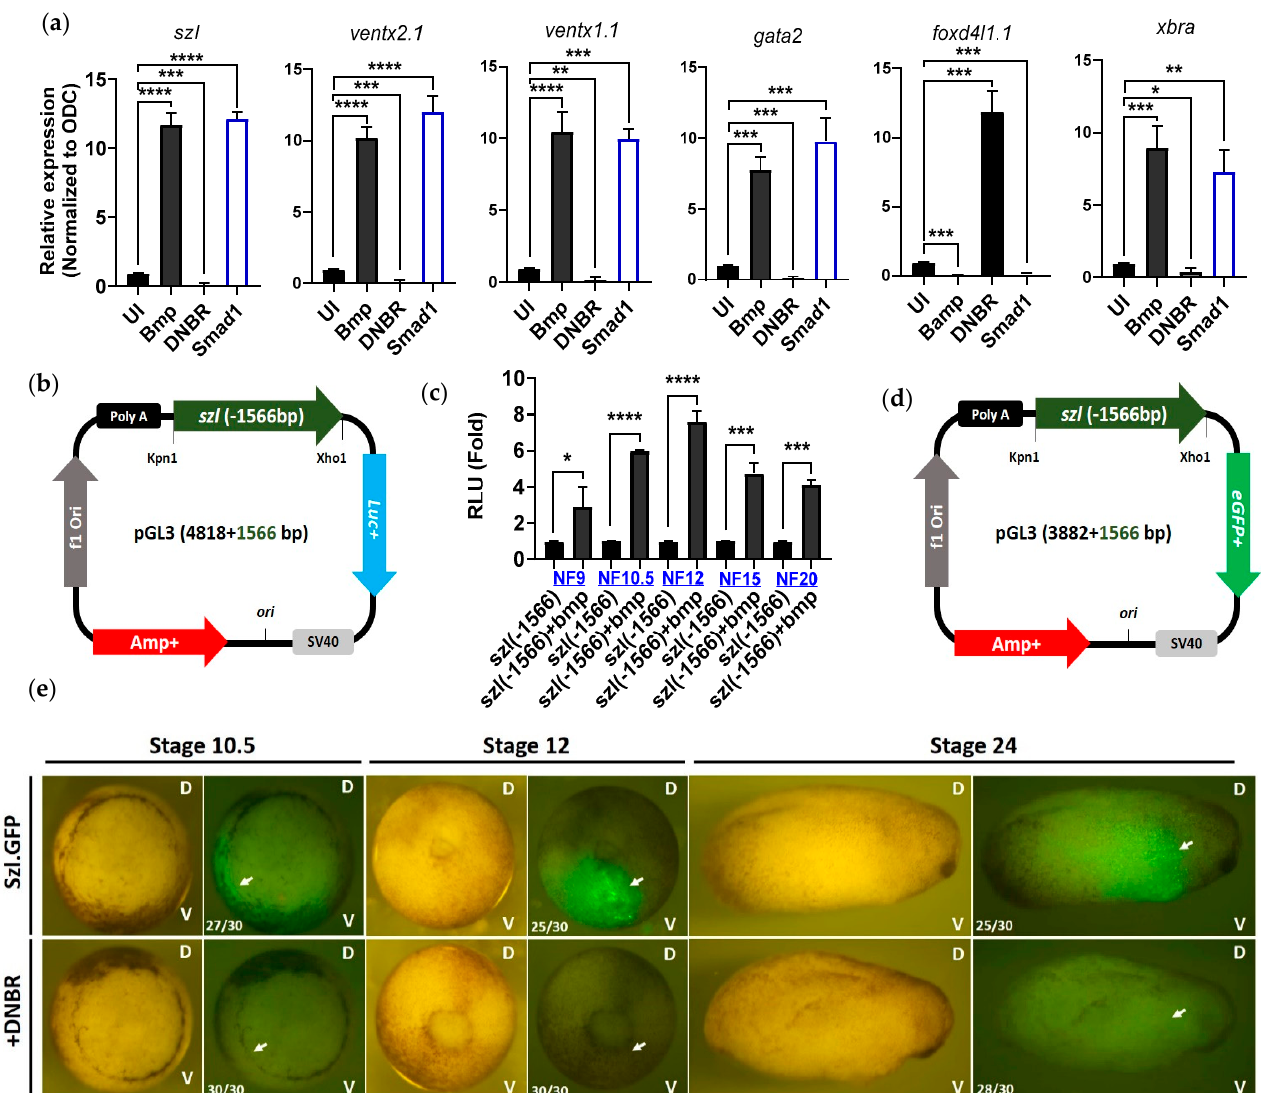
Figure 1. Bmp4 signaling modulates the isolated promoter activity of szl(-1566bp) in a stage-dependent manner: ( a ) Xenopus leavis embryos were injected with bmp4 , dominant negative Bmp4 receptor ( dnbr ) and smad1 mRNAs (1 ng/embryo) at the one-cell stage and animal caps (10 AC/sample) were dissected at stage 8 and grown up to stage 11. Ventral marker genes, including szl mRNA expression, were assayed through quantitative RT-PCR analysis. (UI: uninjected.) The qPCR values were normalized to ODC. ( b ) The Szl(-1566) promoter was cloned into pGL3-luc+ vector. ( c ) Analysis of szl expression at various developmental stages in the presence of Bmp4, the reporter gene activity of the szl(-1566) promoter construct injected with bmp4 mRNA was assayed. Five sets of three, three embryos were used for each sample in each developmental stage. ( a , c ) Unpaired two-tailed Student’s t -test or ANOVA were applied for statistical analysis. p ≤ 0.05 for *, p ≤ 0.01 for **, p ≤ 0.001 for ***, p ≤ 0.0001 for ****, ns (non-significant) were the assignments for significance. ( d ) Szl(-1566) promoter was cloned into the pGL3-eGFP+ vector ( luc was replaced with eGFP ). ( e ) Embryos (30 embryos/sample) were injected with the reporter construct of szl(-1566)-eGFP+ with or without dnbr mRNA and their eGFP fluorescence was observed at stages 10.5, 12 and 24. (D: dorsal, V: ventral.). The arrows indicate the regions of eGFP fluorescence appeared with szl(-1566)-eGFP+ without dnbr mRNA and decreased with dnbr mRNA. To examine the transcriptional regulation of szl , a 1566 bp 5 ′ -flanking region of szl.L from translational start site (TLS) was cloned into pGL3-luc+ (Figure 1b) and pGL3-eGFP+ reporter gene vectors (Figure 1d). The cloned szl(-1566) promoter construct was injected